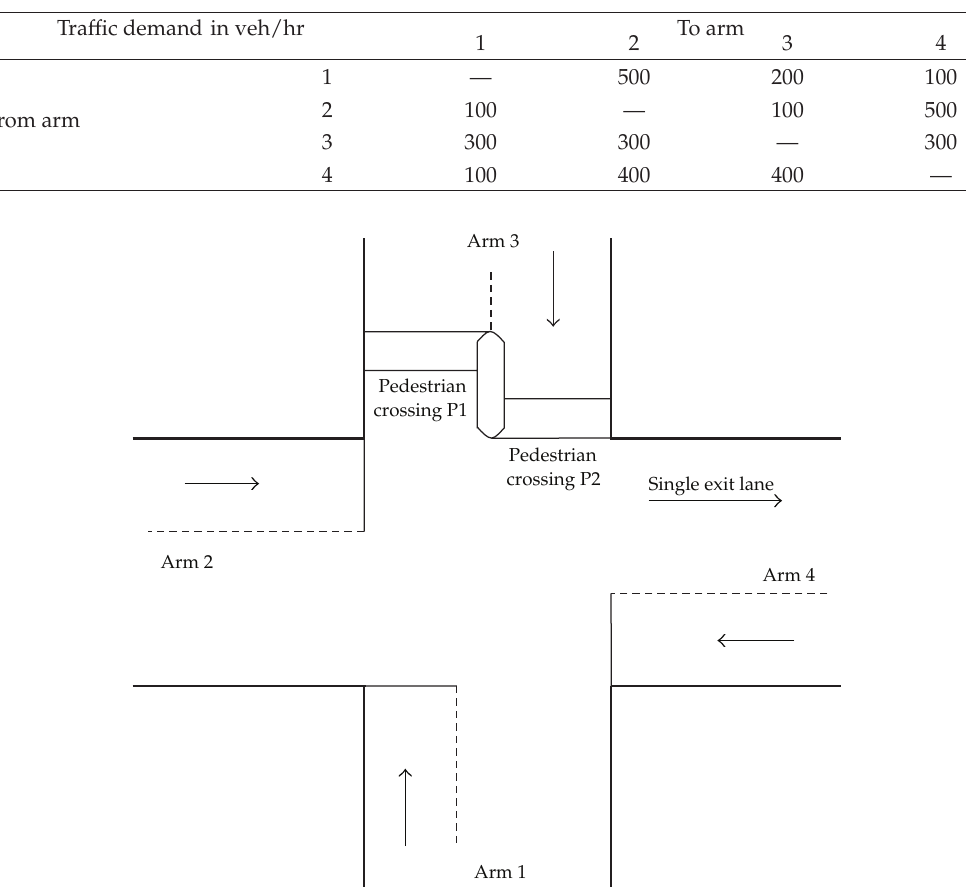
Figure 1: The layout of the four-arm example